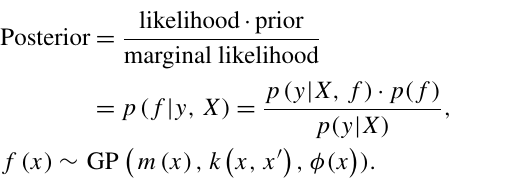
Table 3. Kolmogorov–Smirnov (KS) test for two samples of proba- bility distribution function (PDF).